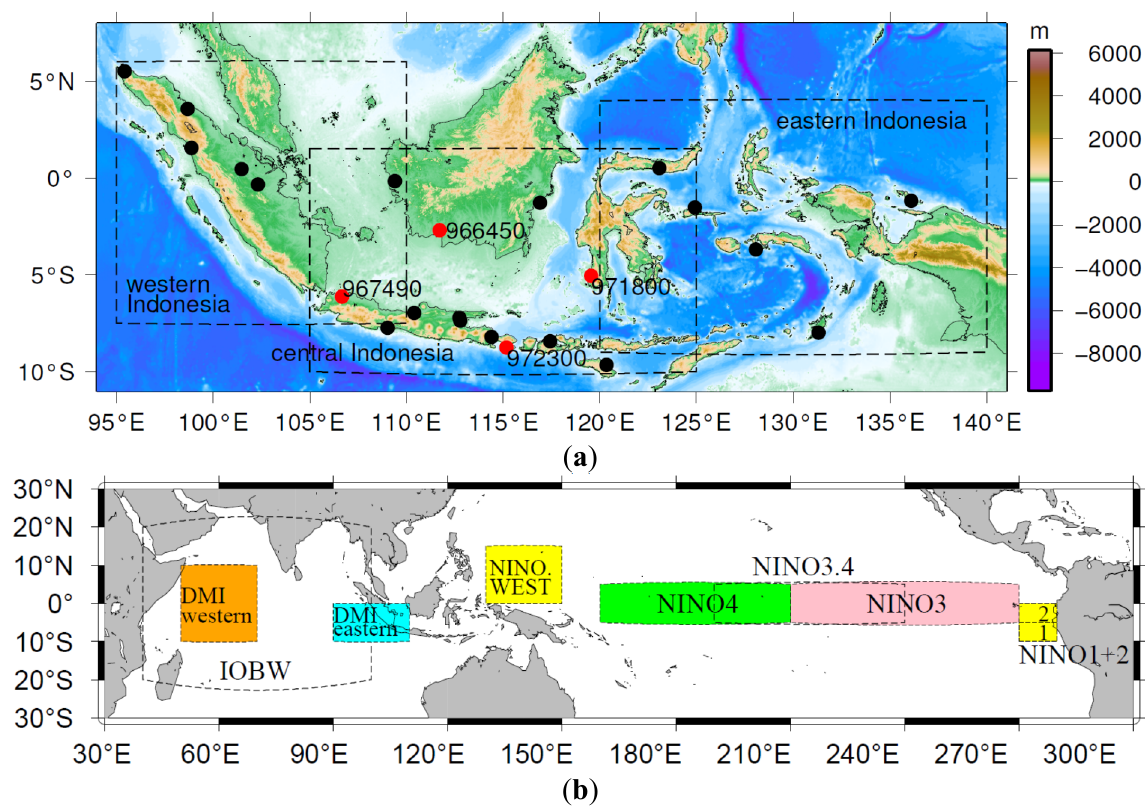
Figure 1. ( a ) Twenty-three weather stations (red and black circles) in Indonesia from the Global Summary of the Day (GSOD), National Climatic Data Center (NCDC), and National Oceanic and Atmospheric Administration (NOAA); three geographic regions were defined in the analysis. The stations in red are used in further analysis (see Table 2). ( b ) Specific SST monitoring regions for the indices of interest: the Multivariate ENSO Index (MEI), the Pacific Decadal Oscillation (PDO), NINO1 + 2, NINO3, NINO3.4, NINO4, NINO.WEST, the Dipole Mode Index (DMI) for the Indian Ocean Dipole and the Indian Ocean Basin-wide (IOBW) index. 1 and 2 in yellow indicates the monitoring regions for NINO1 and